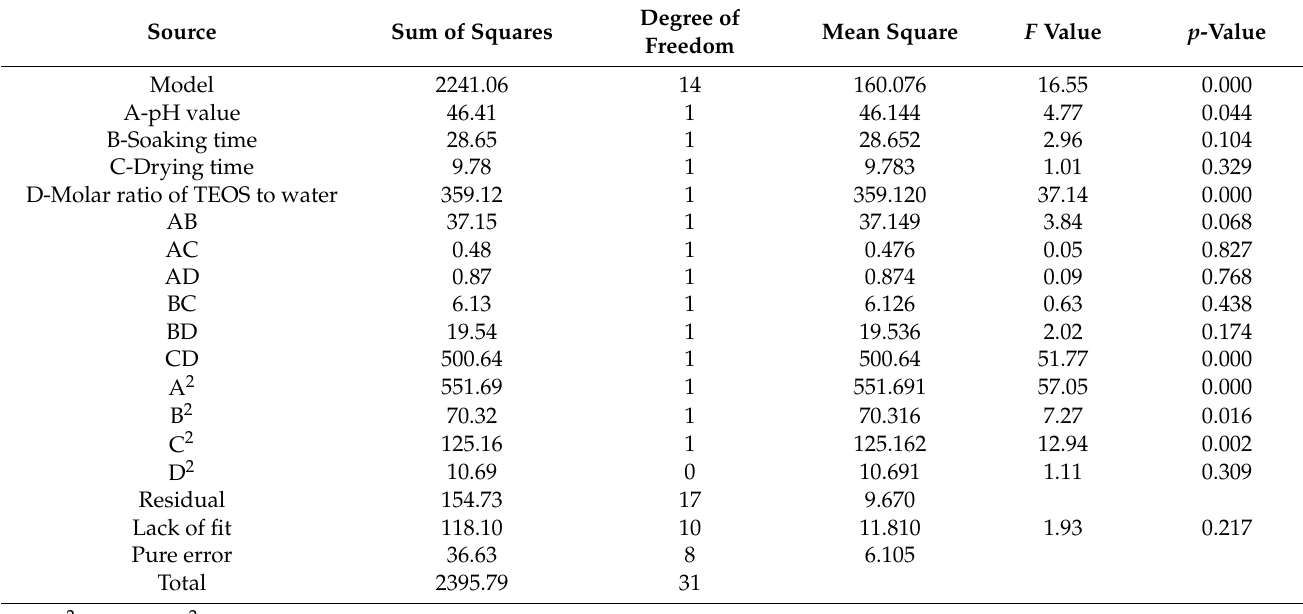
Table 4. Analysis of variance (ANOVA) for the percentage silica